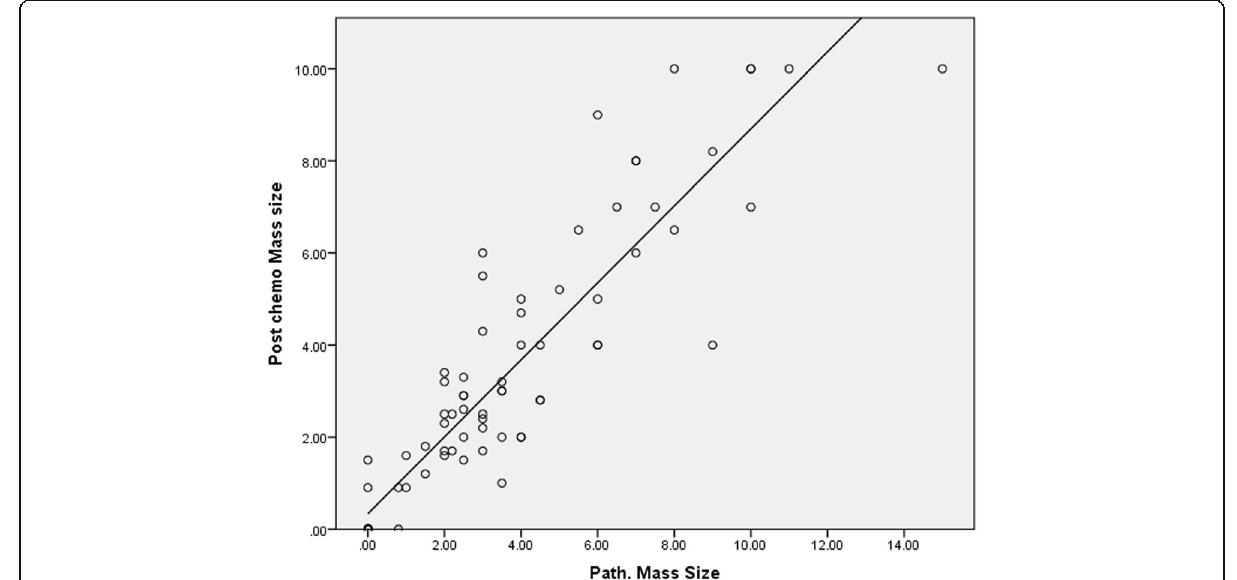
Fig. 8 Scatter plots of maximum tumor diameter measurement between CESM and histopathology